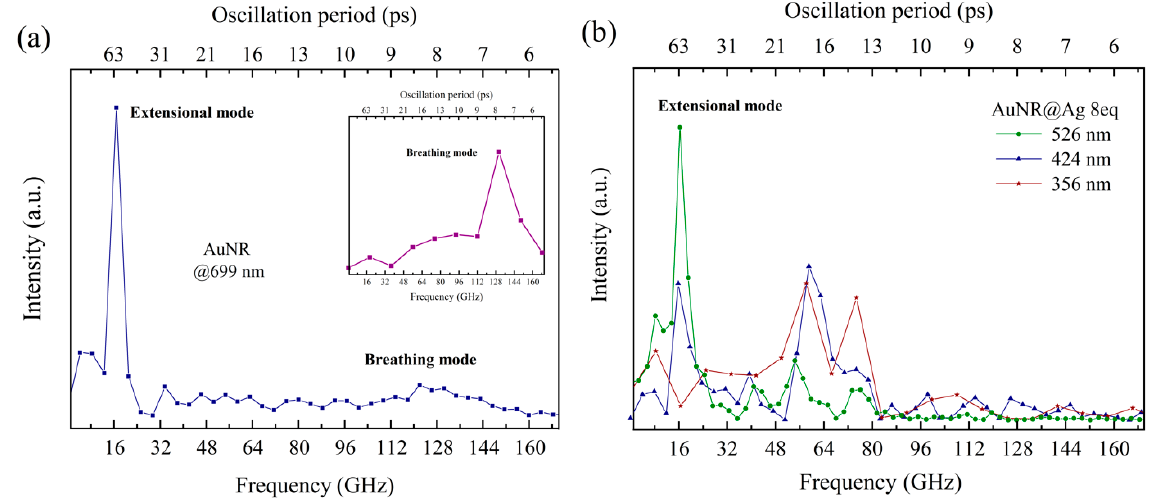
Figure 2. FFT spectra of the TA signal of: ( a ) bare AuNRs probed at 699 nm wavelength (LgSPR domain), ( b ) AuNR@Ag 8eq probed at 526 nm ( L 0 mode domain), 424 nm ( T 1 mode domain) and 356 nm ( T 3 mode domain) wavelengths. The spectra show the intensity of the oscillations in arbi- trary units vs. both the frequency in GHz (bottom axis) and the period in picoseconds (top axis) of the oscillations. The FFT spectrum in the inset of ( a ) was obtained from the TA spectrum acquired with a shorter temporal step size (inset of Figure 1).